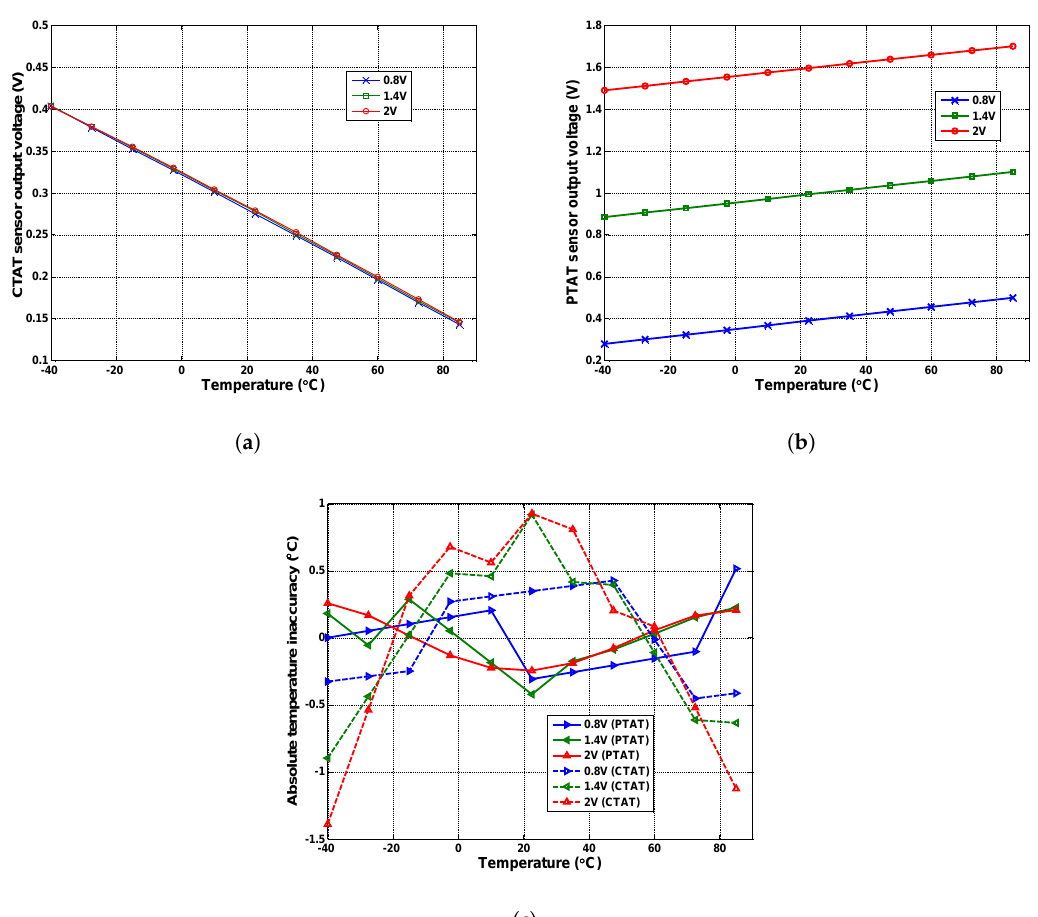
Figure 5. Schematic-level simulation results showing supply dependence of output voltage obtained from: ( a ) CTAT sensor and ( b ) PTAT sensor; and ( c ) their absolute temperature